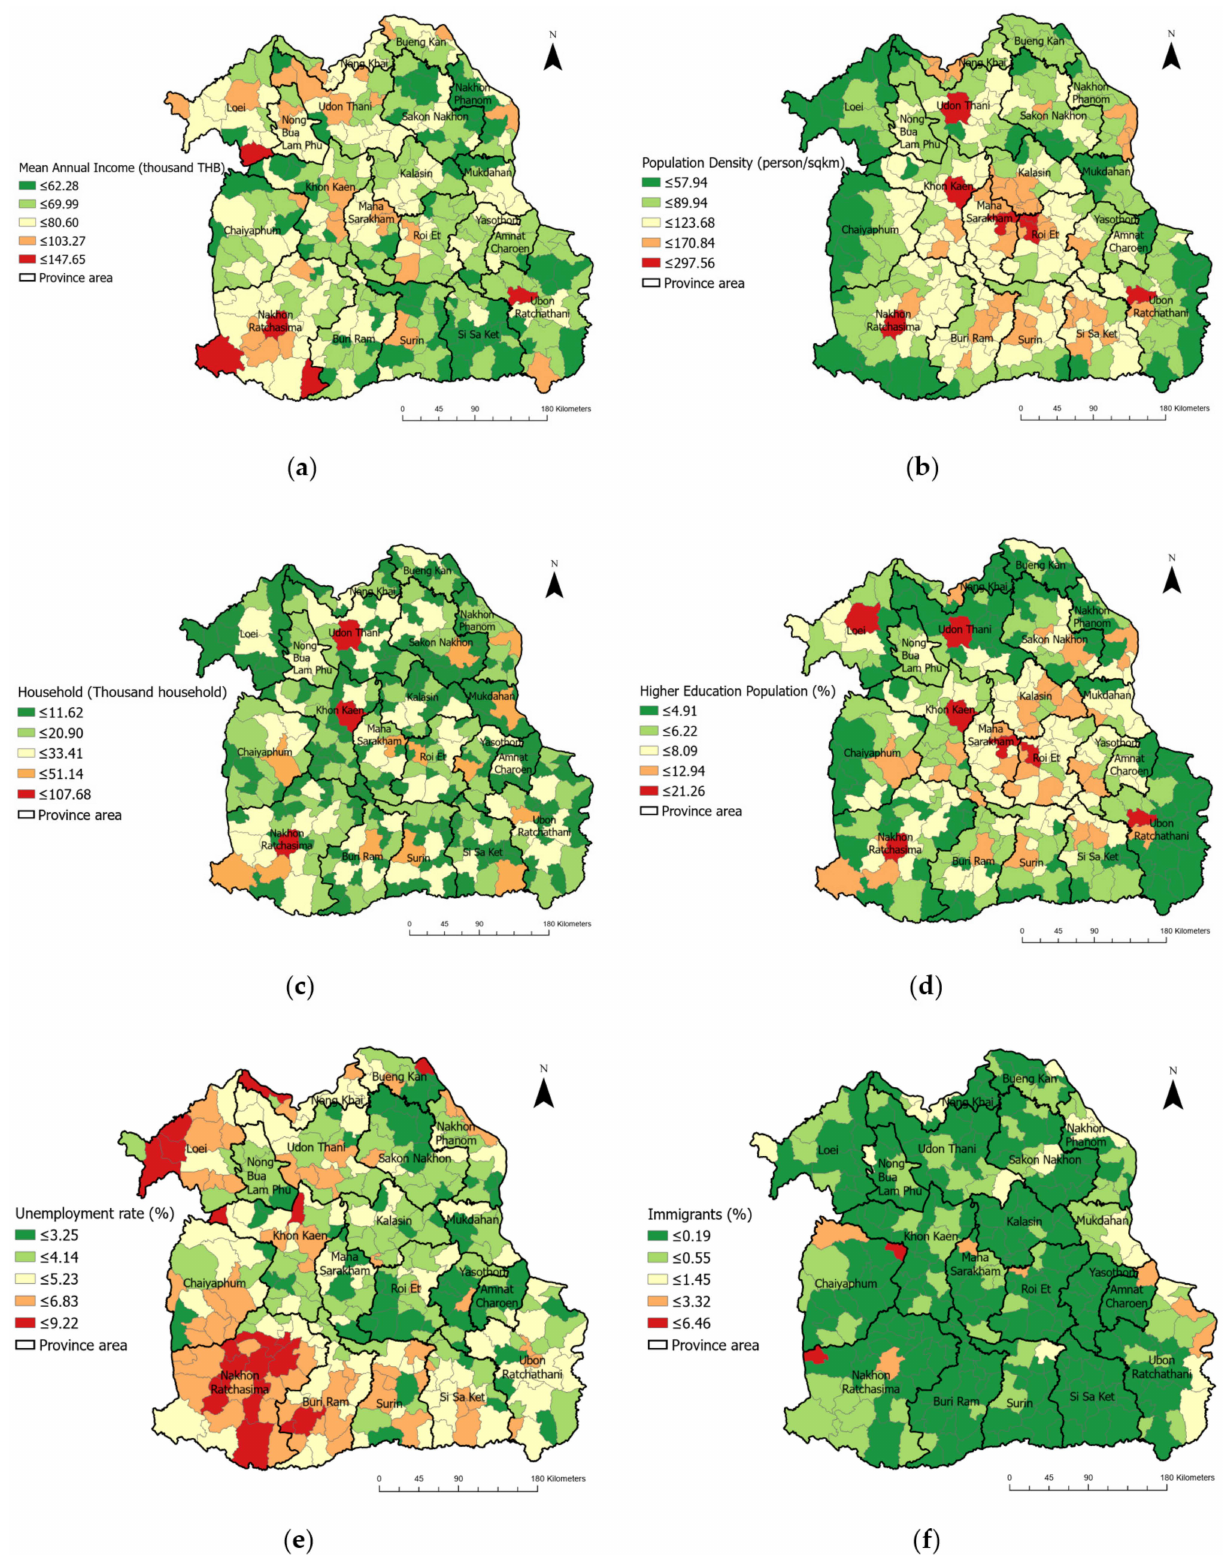
Figure 3. District-level spatial distribution of SES variables across Isaan: ( a ) annual income; ( b ) popu- lation density; ( c ) number of households; ( d ) rate of higher education level; ( e ) unemployment rate; ( f ) proportion of